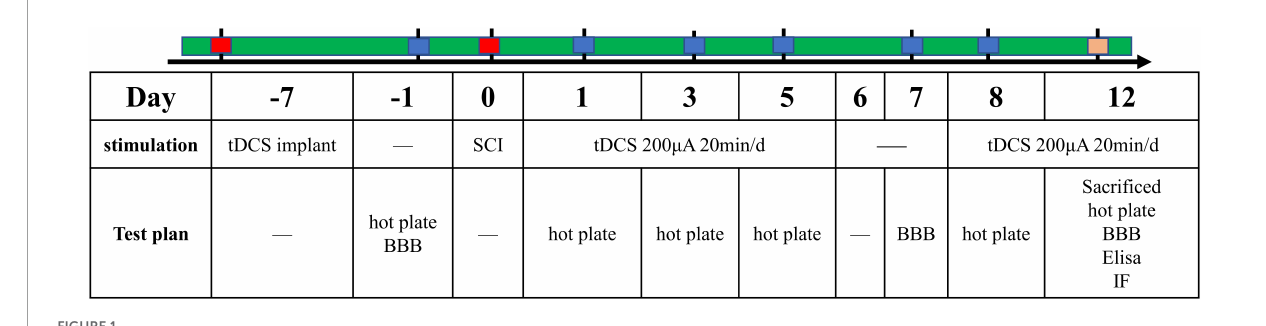
FIGURE1 The time schedule of protocols in the present